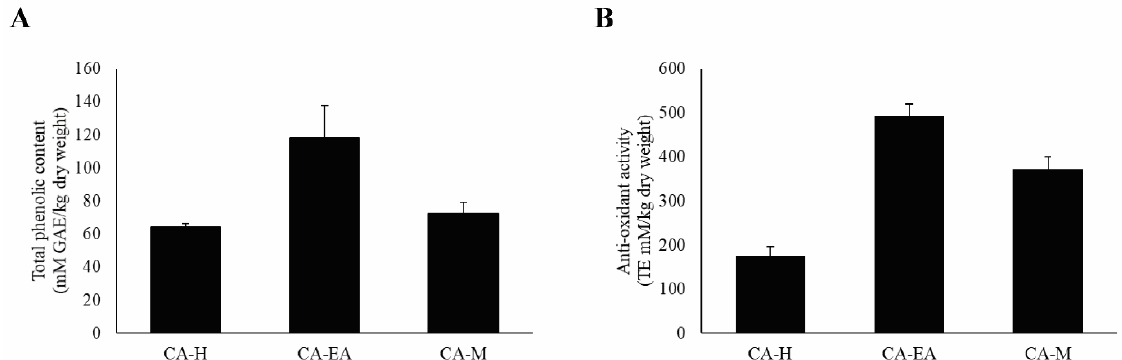
Figure 8. Analysis of antioxidant compounds and antioxidant capacity of CA extracts. ( A ) Total phenolic content of CA extract. ( B ) Antioxidant activity of CA extracts. Data are shown as mean ± SD of at least three independent experiments.